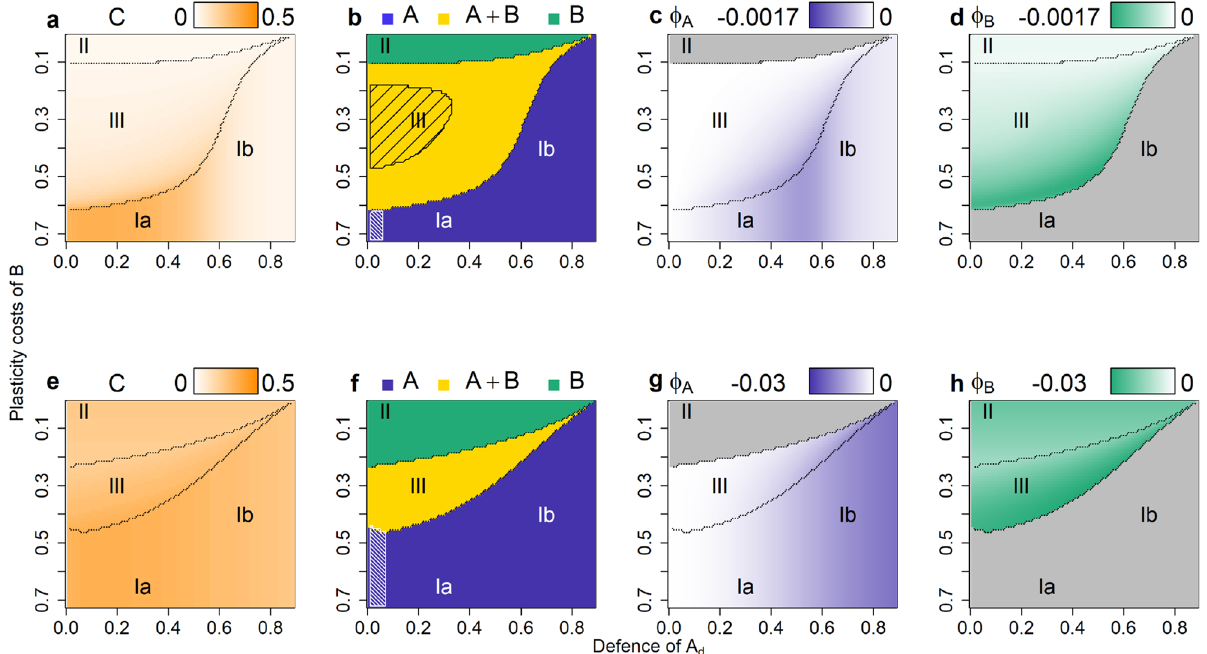
Figure 3. Consumer biomass, autotroph coexistence and maladaptive switching for the scenarios parallel 0.01 ( a – d ) and parallel 1 ( e – h ) . Consumer biomass ( a , e ), the autotroph coexistence patterns ( b , f ), and the autotrophs’ maladaptive switching Φ ( c , d , g , h ) (higher biomasses or more intensive maladaptive switching are shown by darker colours). Lines separate the regions I–III of different autotroph coexistence. The y-axis is reversed to follow the pattern of increasing fitness. Grey areas in ( c , d , g , h ) depict areas where the species was extinct. Shaded areas in b and f depict oscillating systems (quarter-lag predator–prey cycles in dense shading, antiphase cycles in loose